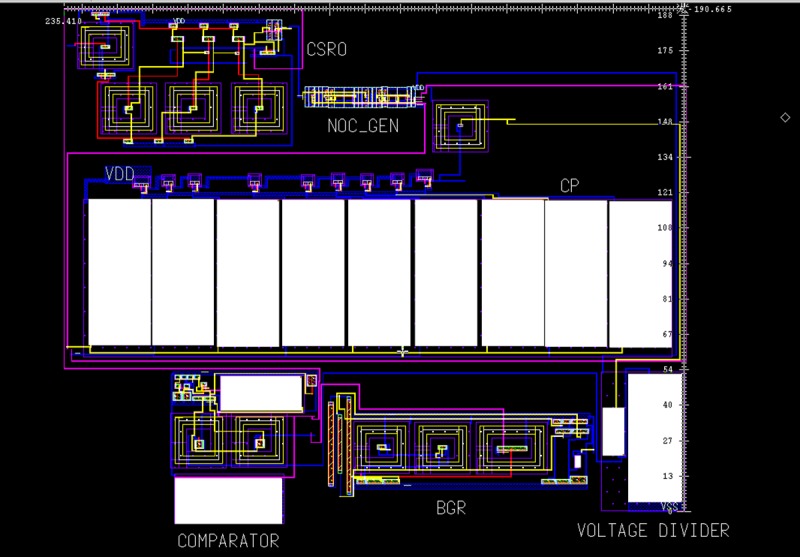
Die layout of the proposed HVG circuit without pads.